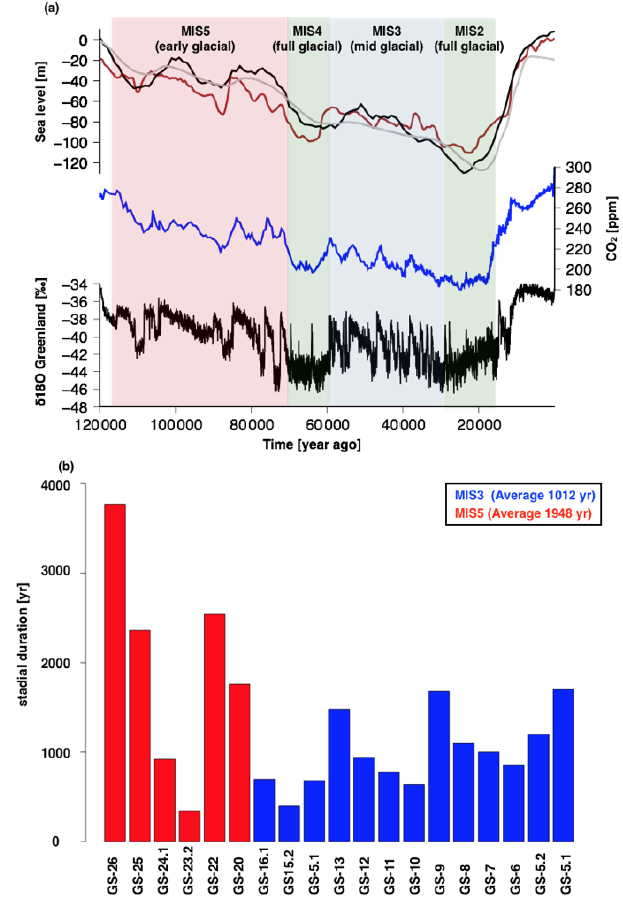
Figure 1. (a) Changes in ice volume (sea level, black: Spratt and Lisiecki, 2016; brown: Grant et al., 2012; gray: Abe-Ouchi et al., 2013), CO 2 (Bereiter et al., 2015) and Greenland ice core δ 18 O (a proxy of temperature, Rasmussen et al., 2014) over the last glacial– interglacial cycle. (b) Duration of stadials during MIS5 and MIS3. Color shading in panel (a) separates the period within one glacial cycle. Green: MIS2, MIS4; blue: MIS3; and red: MIS5a–d. During MIS2 and MIS4, the glacial ice sheets were most extensive and the CO 2 concentration was low. During MIS3, the glacial ice sheets were relatively small and the CO 2 concentration was higher than those of MIS2 and MIS4. During MIS5a–d, the glacial ice sheets were smallest and the CO 2 concentration was highest among the glacial